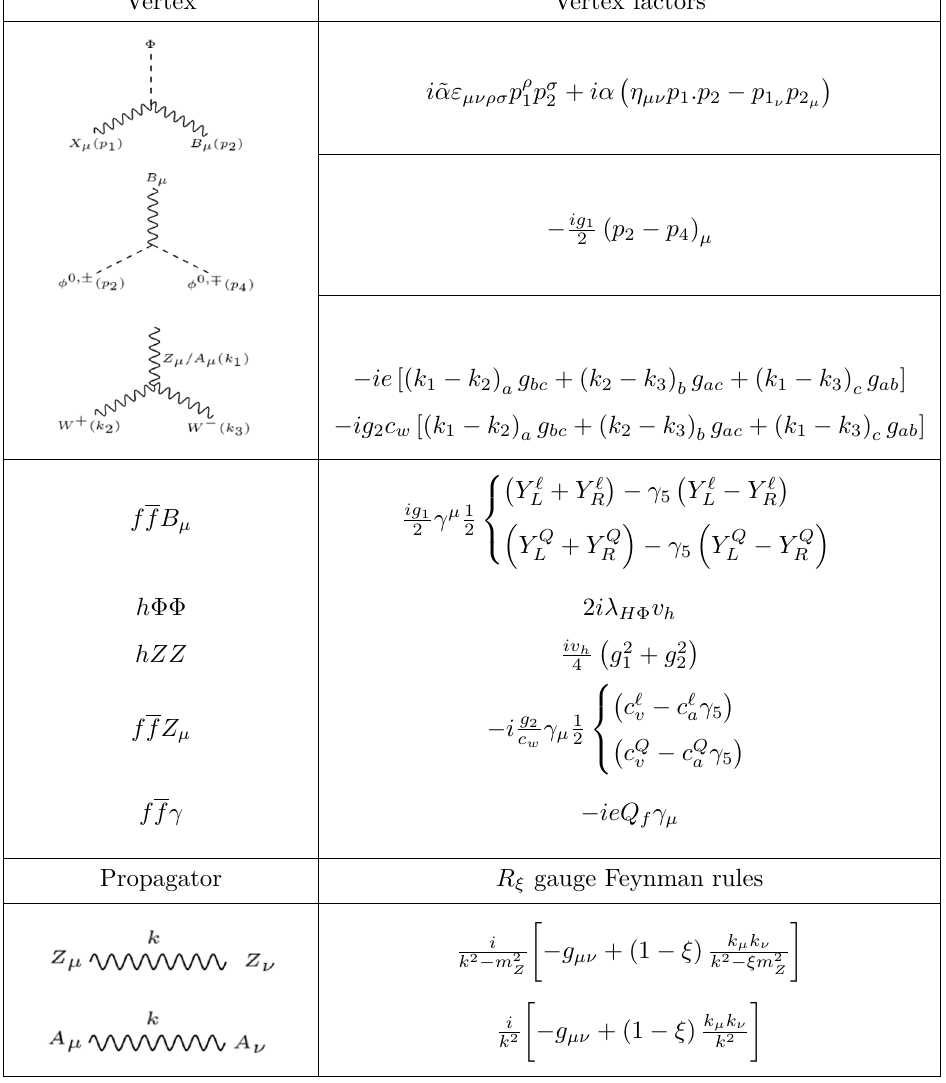
Table 3 . Relevant DM-SM interaction vertices and vertex factors along with SM propagators. All momenta are assumed flowing towards the vertices. Here ‘ stands for SM leptons and Q stands for the SM quark generations. Y ‘ ( Q ) is the hypercharge for left and right-chiral leptons L,R